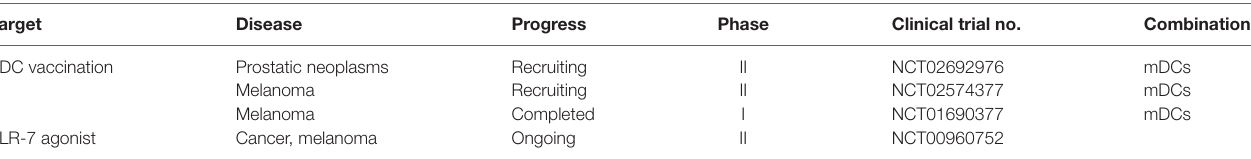
TAble 2 | Clinical trials of pDCs in various